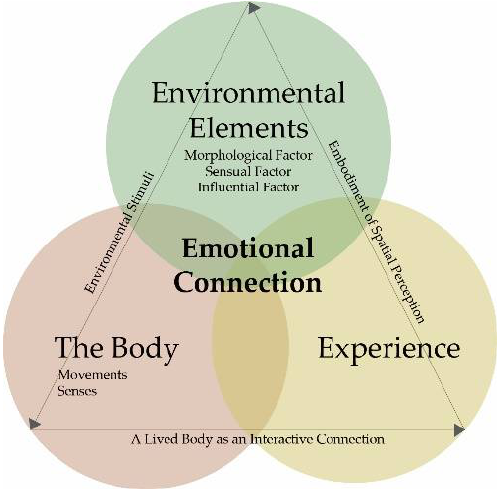
Figure 6. Embodiment of spatial experience for emotional connection. Source: author’s drawing.